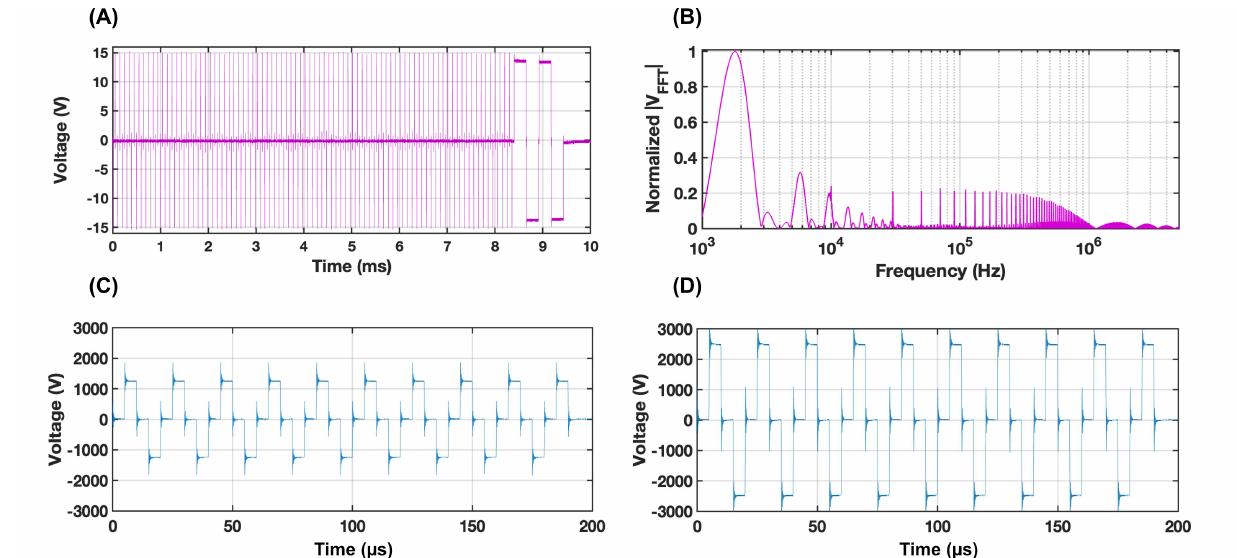
Figure 2. ( A ) The custom diagnostic FAST acquisition waveform delivered between therapeutic voltage bursts creates ( B ) a normalized frequency spectrum of the absolute FFT voltage magnitude, which was then used to collect real-time impedance measurements from our agar phantom. Delivered waveforms for the respective low-voltage ( C ) and high-voltage ( D ) groups are also